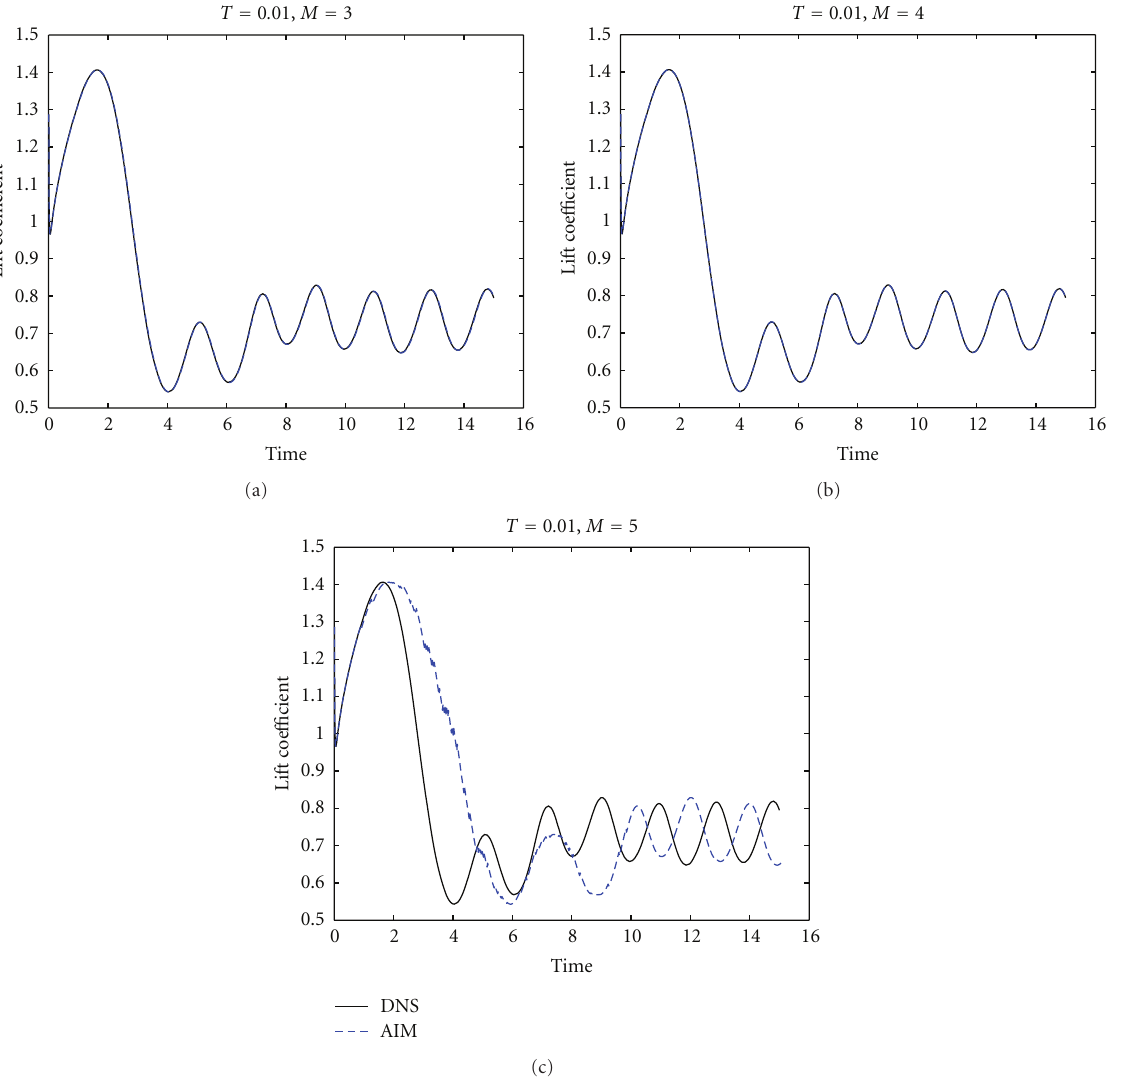
Figure 5: Transient dynamics: Re = 400, lift coe ffi cient for T = 0 . 01 with various number of M . From top to bottom: M = 3,4, and 5.